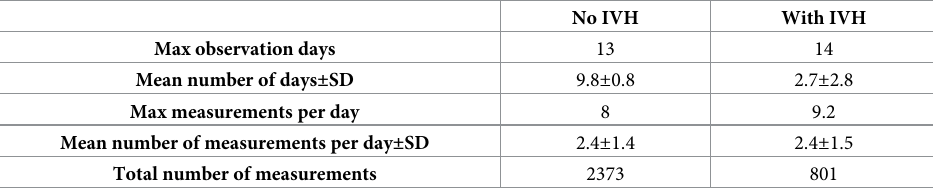
Table 3. Number of observation days and measurement samples per infant for the control and affected